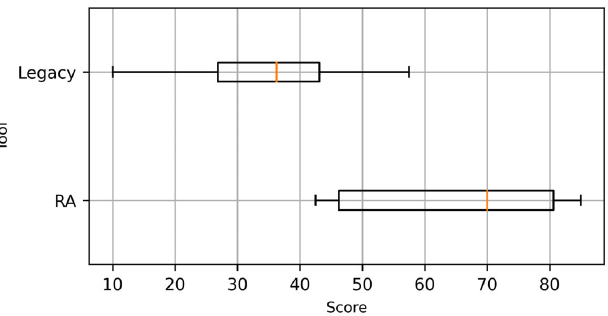
Figure 12. The box plot shows the distributions among the SUS questionnaires for the two tools. On average, the RA tool scored better compared to the legacy tool.